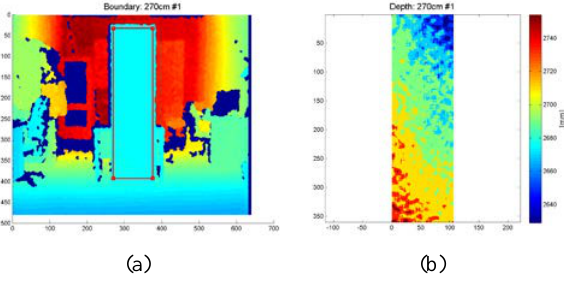
Figure 1. Kinect XBOX 3600 sensor, including 2D and 3D Figure 3. Pseudo color 3D images taken at 270 cm ranges; imaging sensors. entire image (a) and image of the planar target extracted (b).